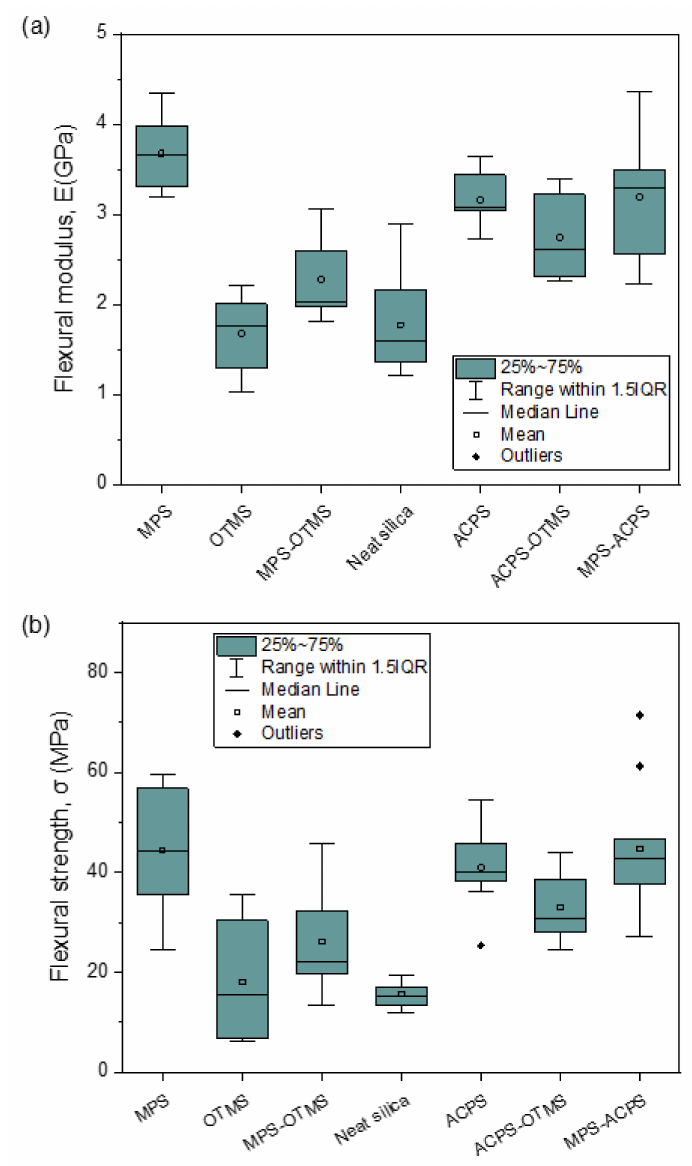
Figure 8. ( a ) Flexural modulus bar plots; ( b ) Flexural resistance box plots for the experimental dental nanocomposite resins filled with different silica